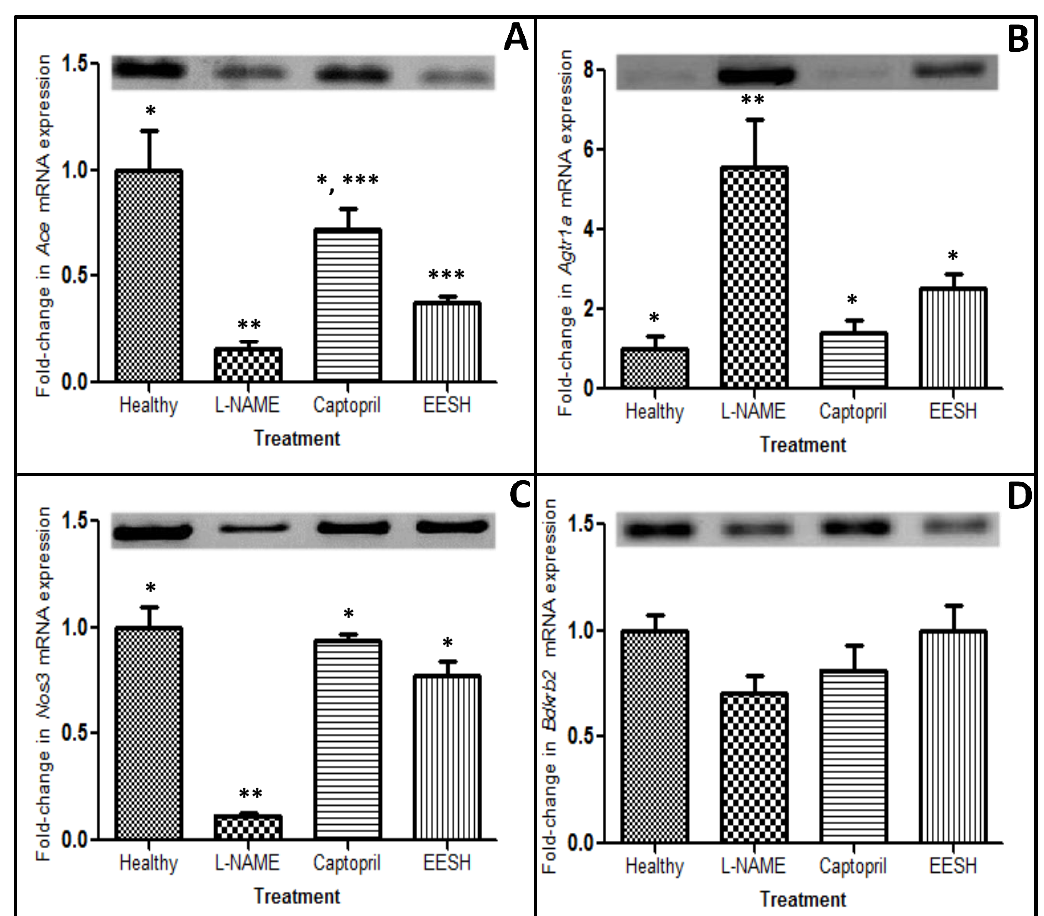
Figure 1. Comparison of the expression of Ace ( A ), Agtr1a ( B ), Nos3 ( C ) and Bdkrb2 ( D ) genes in hypertensive rats subjected to different treatments. Data are normalized to the Gapdh gene and fold changes between treatments are expressed as mean ± standard deviation. Upper panels show representative gel bands. Different symbols (*, ** or ***) represent significant differences (ANOVA test; p ≤ 0.05). ANOVA: analysis of variance, EESH: ethanolic extract of Salvia hispanica L. seeds; L-NAME: N-nitro-L-arginine methyl ester.